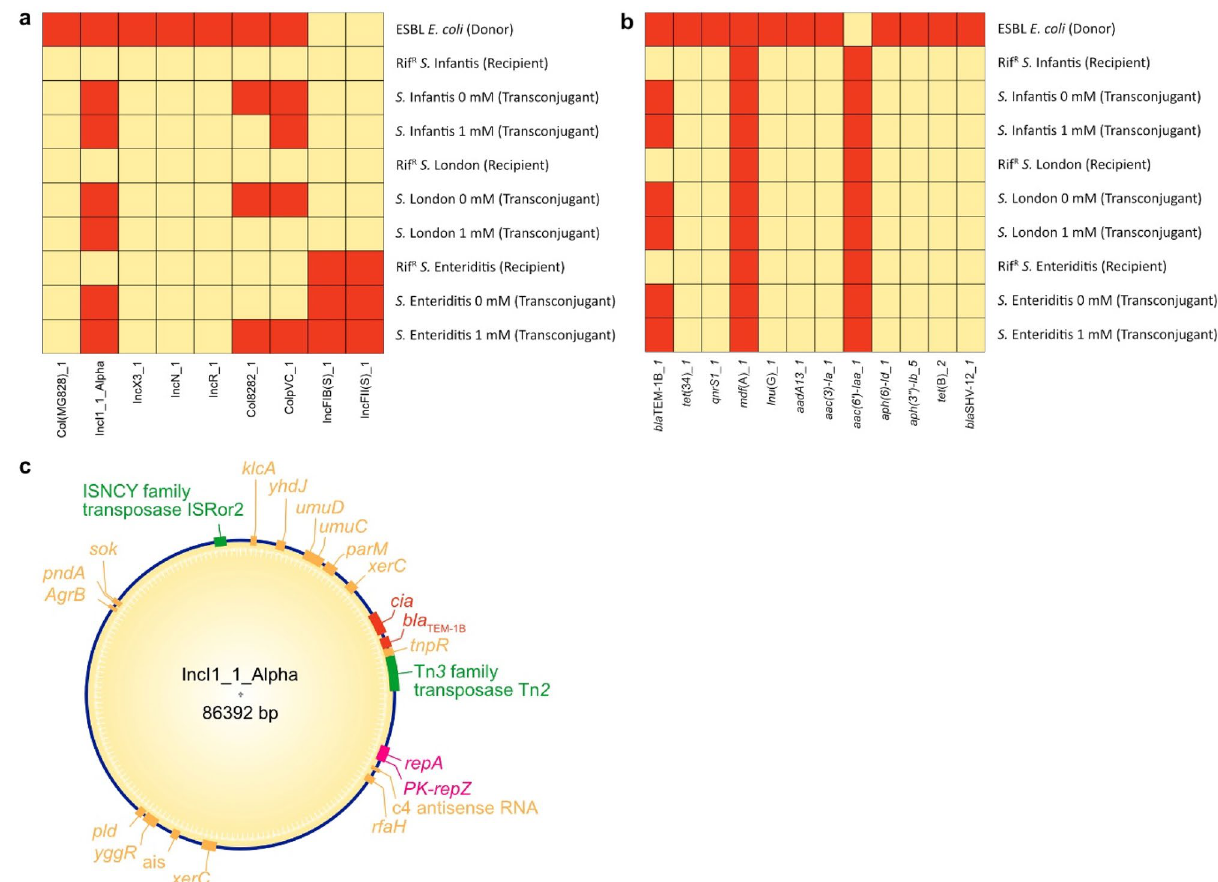
Figure 4. Results of the WGS analysis via ABRicate, represented in the form of heatmaps, showing ( a ) comparison of observed plasmids and ( b ) antimicrobial resistance genes (highlighted in red) between donor, rif R recipients, and transconjugants of the conjugation assay with Zn(NO 3 ) 2 . ( c ) Reconstruction of the transferred plasmid from donor to recipients (transposases highlighted in green; genes involved in plasmid replication highlighted in purple; genes involved in AMR highlighted in